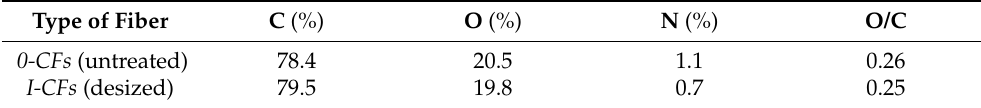
Table 1. Comparison of atomic concentrations and O/C ratio on